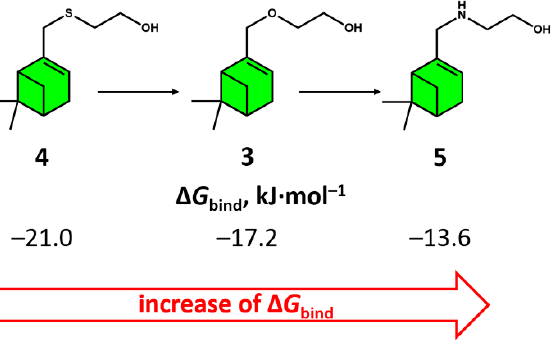
Figure 3. The change of the Gibbs free energy ( Δ G bind ) of terpenoids 3–5 binding to P2Y 12 .